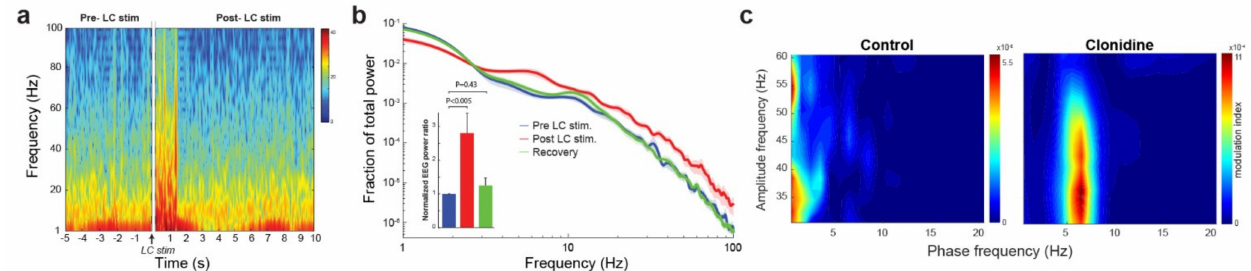
Figure 2. The causal effect of the noradrenergic system on neural oscillations: ( a ) Spectrogram of cortical EEG around phasic LC stimulation. ( b ) LC stimulation resulted in a significant increase in EEG power ratio in a high frequency (10–100 Hz) to low frequency (1–10 Hz); blue (pre LC stim), red (post LC stim), green (recovery); adopted from [105]. ( c ) Manipulation of the noradrenergic system through Clonidine administration, an alpha-2 agonist, altered phase-amplitude coupling of cortical EEG (2 mice, 9 sessions; unpublished data from the